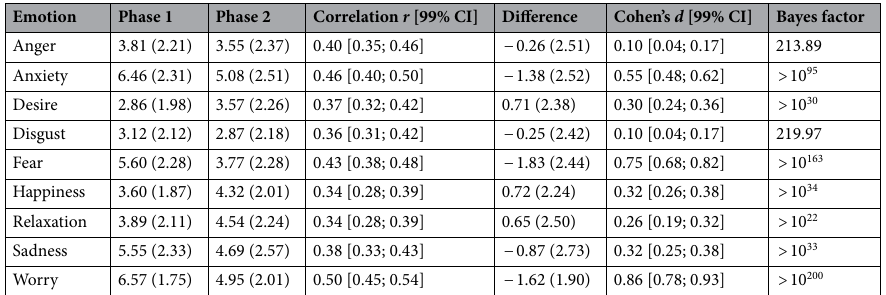
Table 2. Mean (SD) emotion scores in both phases with effect size, BF and correlation for paired comparison. Positive difference scores imply that the values were larger in phase 1 than in phase